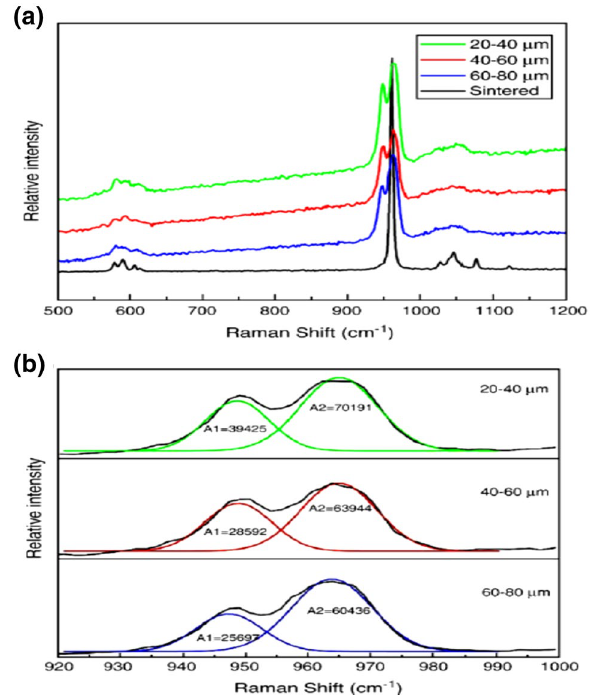
Fig. 4 Raman microprobe spectra (RMS) of a sintered HAp and thermally sprayed HAp b Peak area analysis [66]